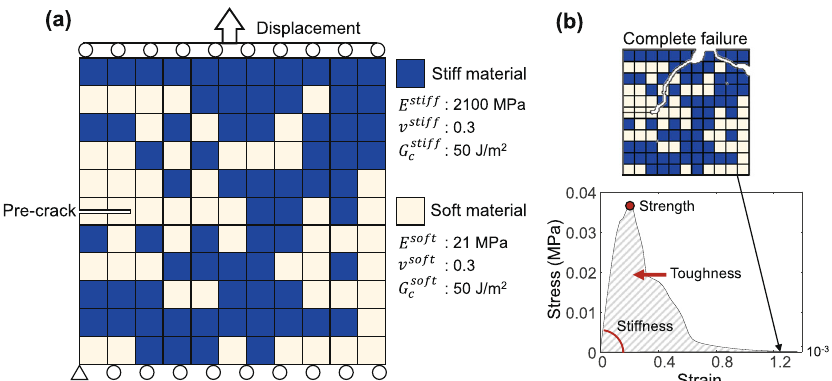
Fig. 2 Schematic of 11 × 11 grid composite data generation. a Schematic of 11 × 11 grid composite composed of stiff and soft materials, and ( b ) the process for obtaining mechanical properties of composite based on the stress-strain curves. The tensile deformations are applied until the complete failure of composite, i.e., no load-bearing capacity.